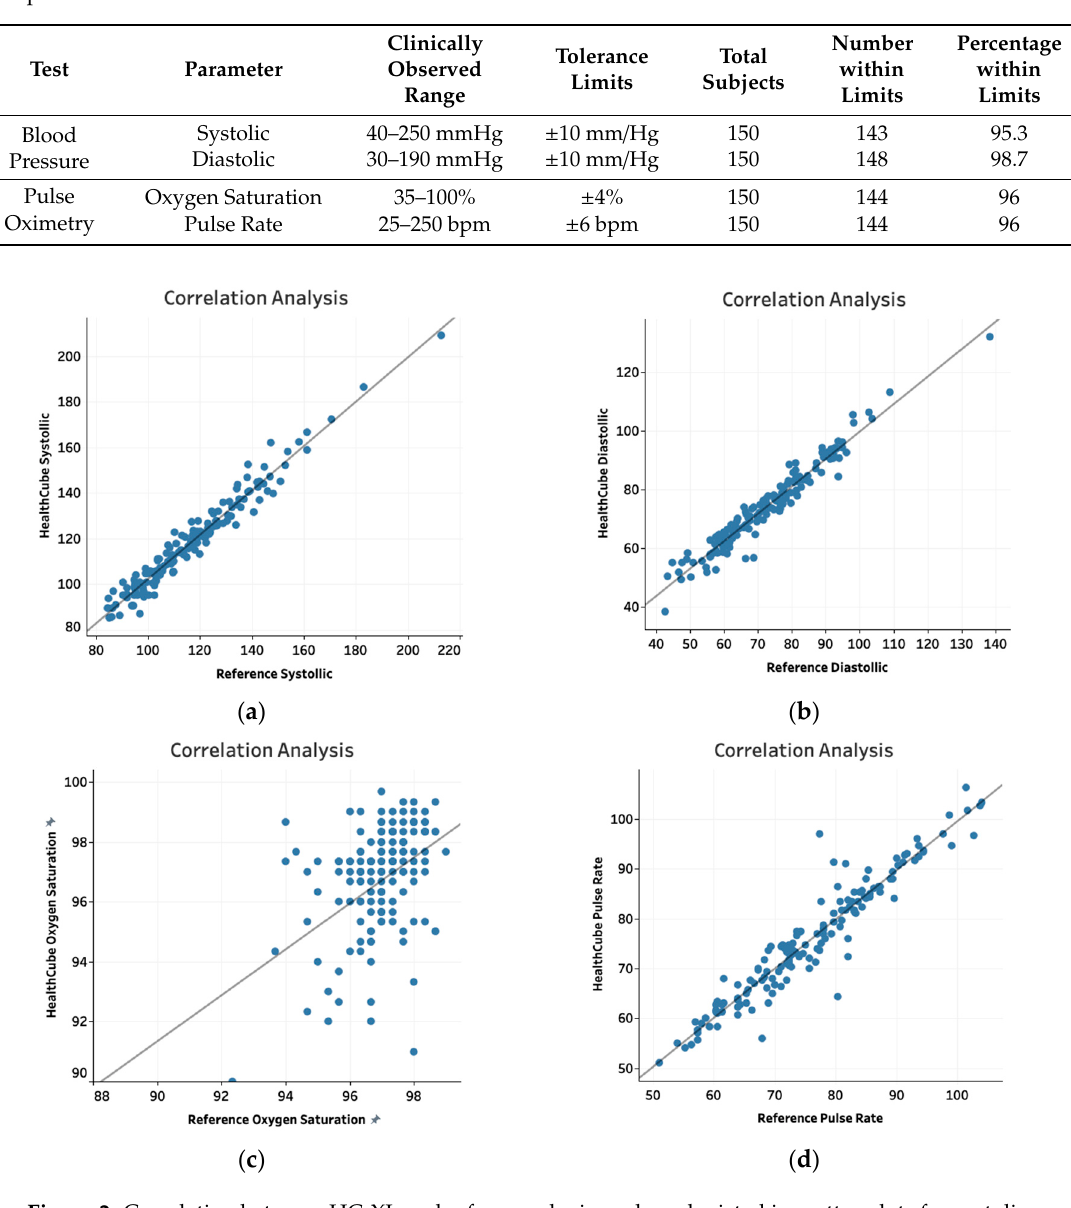
Figure 2. Correlation between HC-XL and reference device values depicted in scatter plots for systolic pressure (a), diastolic pressure (b), oxygen saturation (c) and pulse rate (d) pressure ( a ), diastolic pressure ( b ), oxygen saturation ( c ) and pulse rate ( d